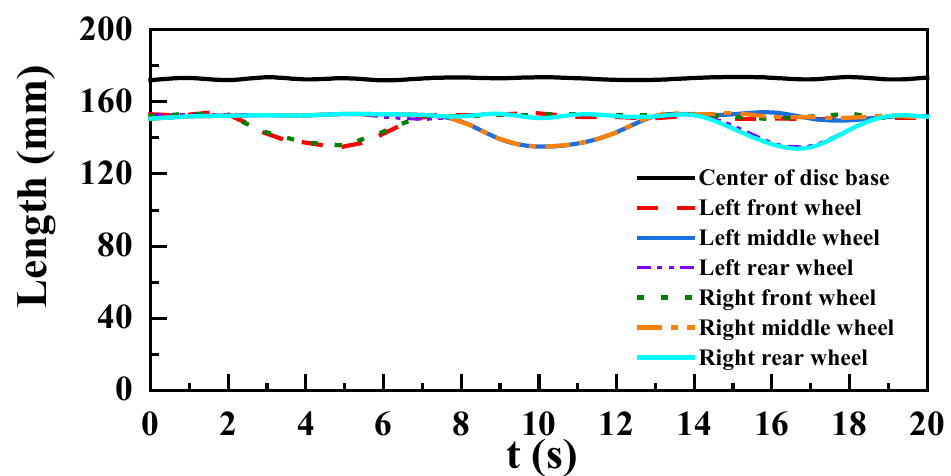
Figure 18. Motion track of the center of the flat plate and the wheel in the process of bilateral obstacle crossing.